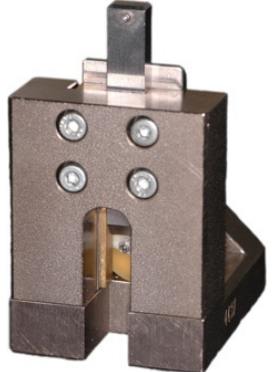
Figure 3. Shear bond strength test.